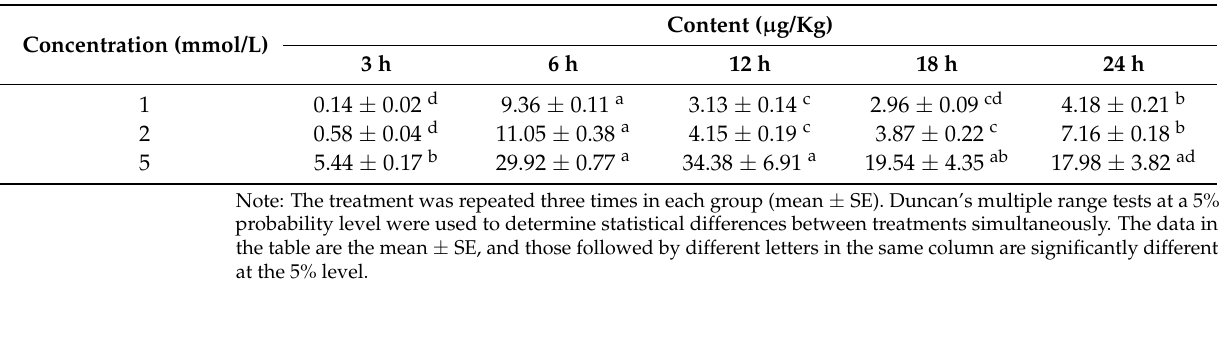
Table 3. Contents of compound 4c in the root of castor plant by different